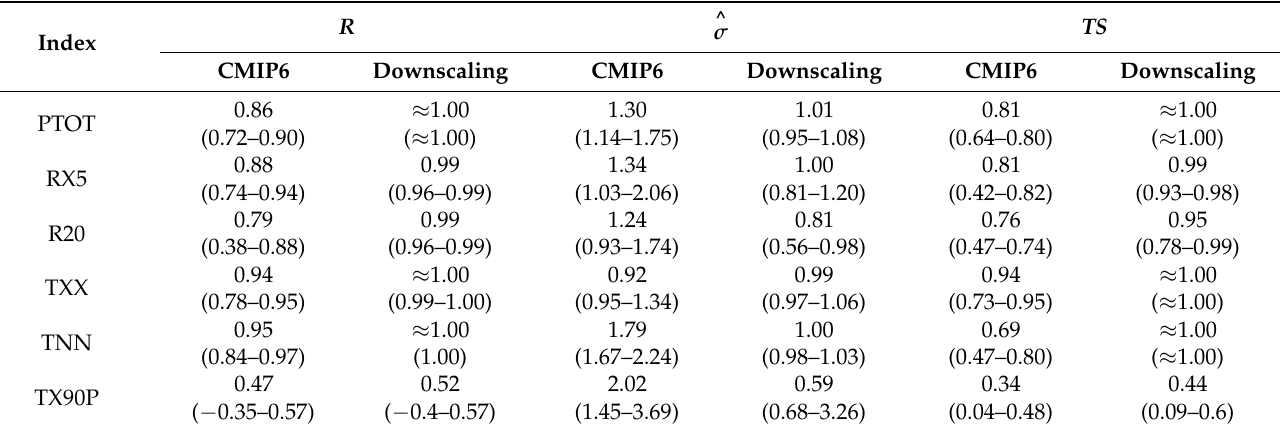
Table 3. Performance of extreme climate indices for CMIP6 climate models and SD correction.